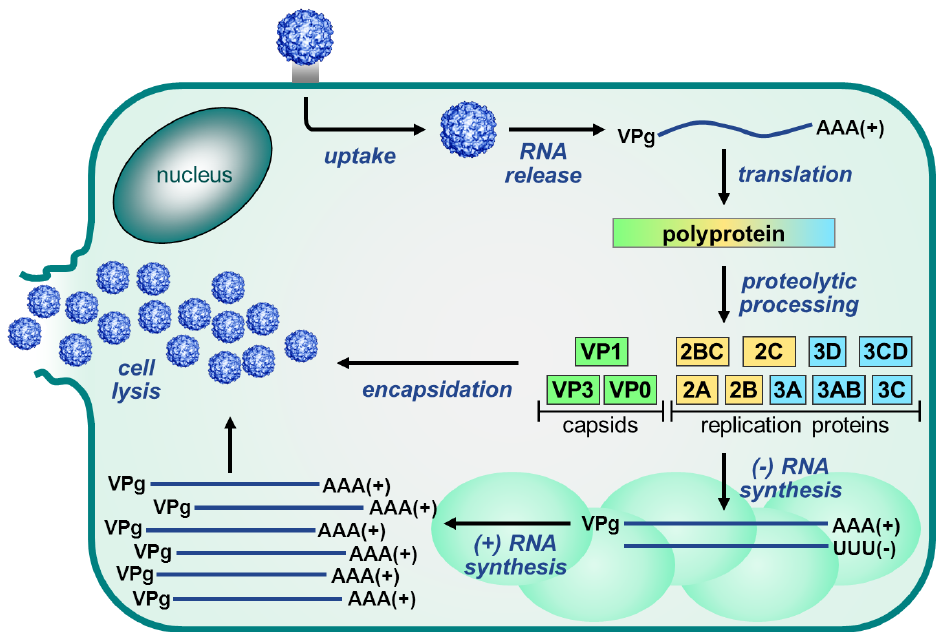
Figure 3. Enterovirus replication cycle. The Enterovirus replication cycle is initiated by binding of the virus to the receptor and internalization into the cell. Subsequently, the viral RNA genome is released from the virion and translated into a single polyprotein which